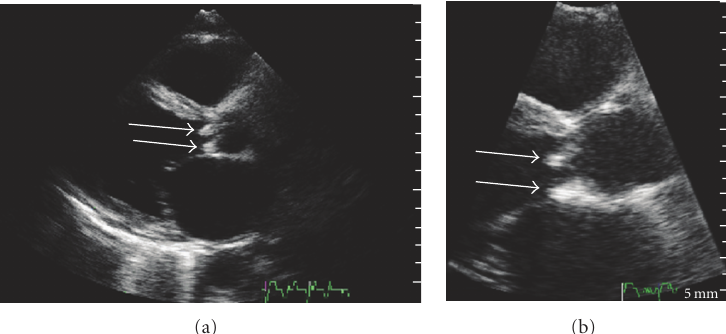
Figure 2: Transthoracic echocardiographic examination: parasternal long axis view. The arrows indicate two vegetations on the ventricular side of the aortic valve cusps (right and